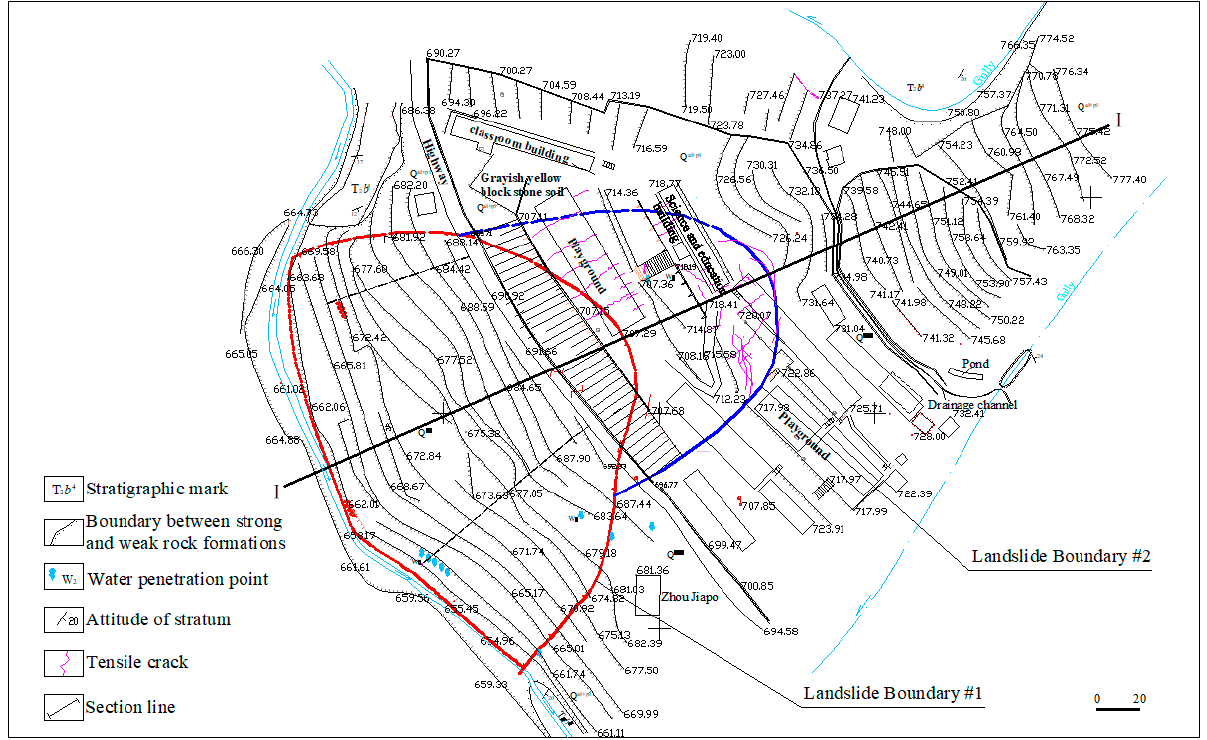
Figure 2. Plane diagram of landslides.